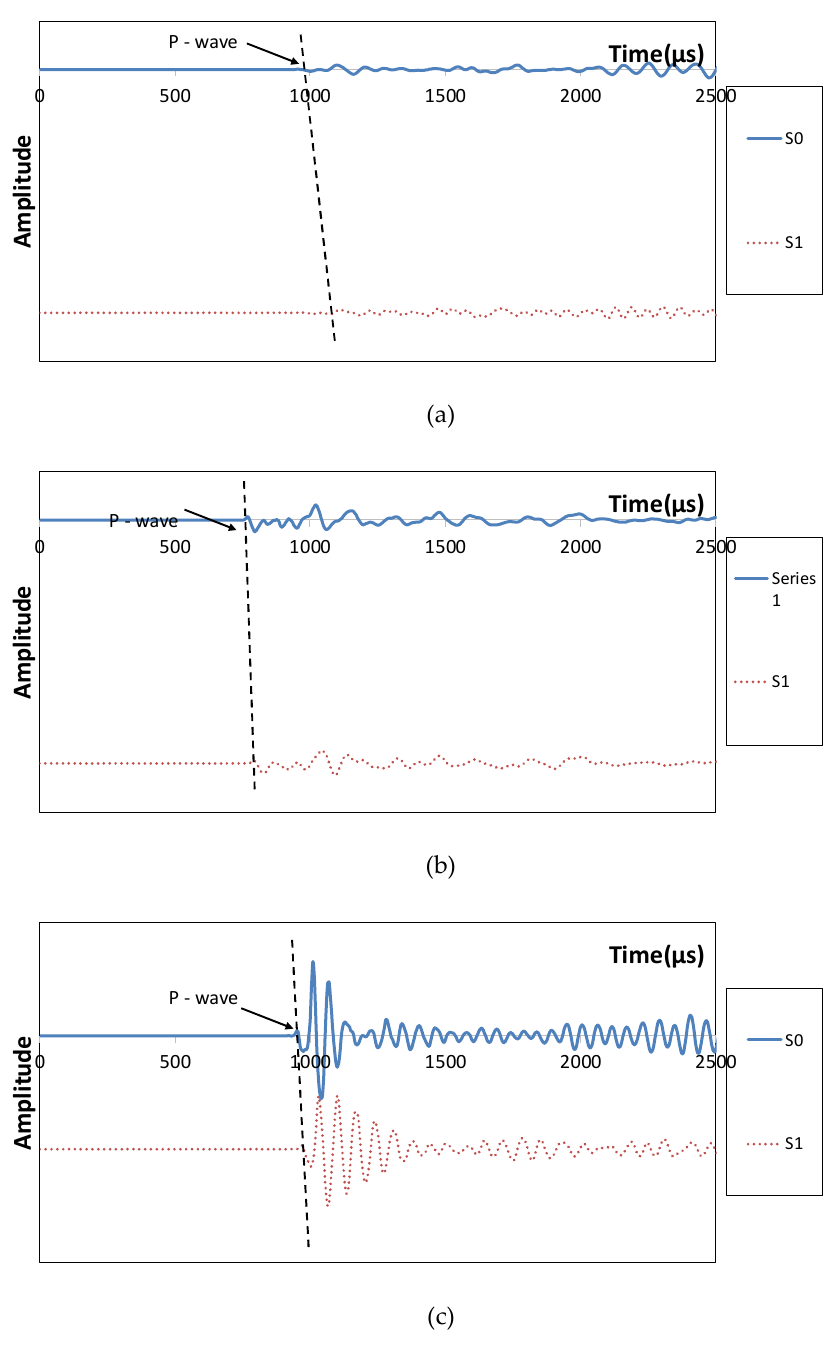
Figure 3. Amplitude versus time graph obtained from S0 concrete cube specimen on ( a ) day-1, ( b ) day-7 and ( c ) day-28